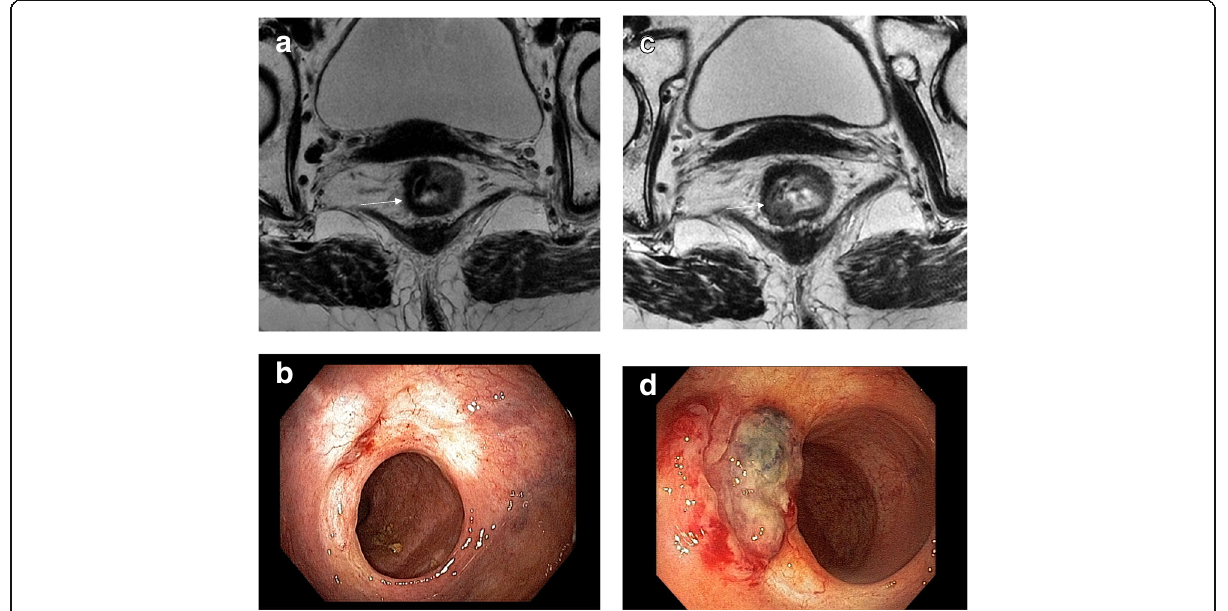
Fig. 13 Luminal regrowth detected by MRI and endoscopy. a High-resolution T2WI restaging after 8 weeks of completion of CRT shows a low signal intensity fibrotic full-thickness scar extending from 5 to 12 o ’ clock (arrow). The patient was referred to watch-and-wait. b The endoscopic view of the treated lesion after 8 weeks of completing CRT shows whitening of the mucosa with some telangiectasia and no significant residual ulceration. c Follow-up after 16 months of completion of CRT shows increased signal intensity where the scar was previously seen from 6 to 9 o ’ clock (arrow). The patient was referred to salvage resection with total mesorectal excision. A clear margin resection was performed. d The endoscopic view of the treated lesion after 16 months of completing CRT shows evident tumor